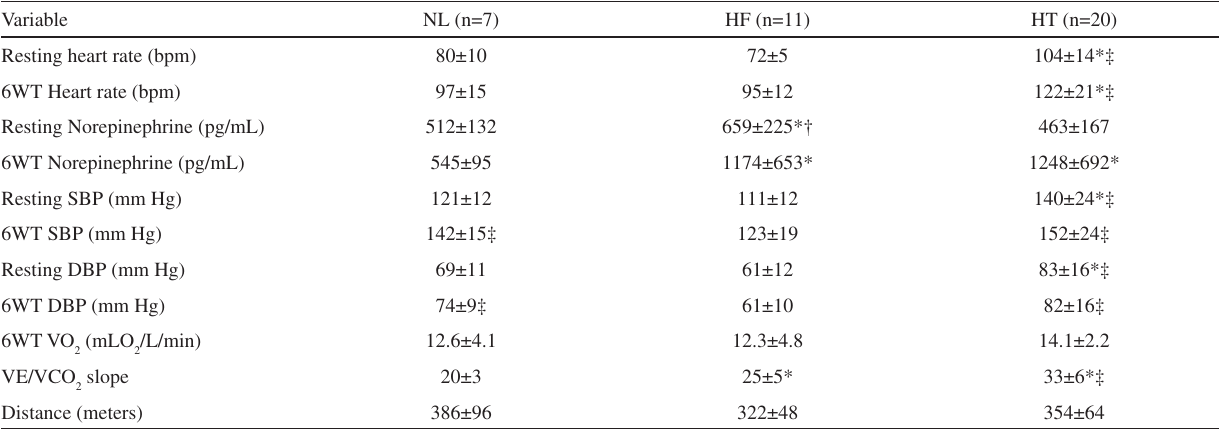
Table 2 - Differences between